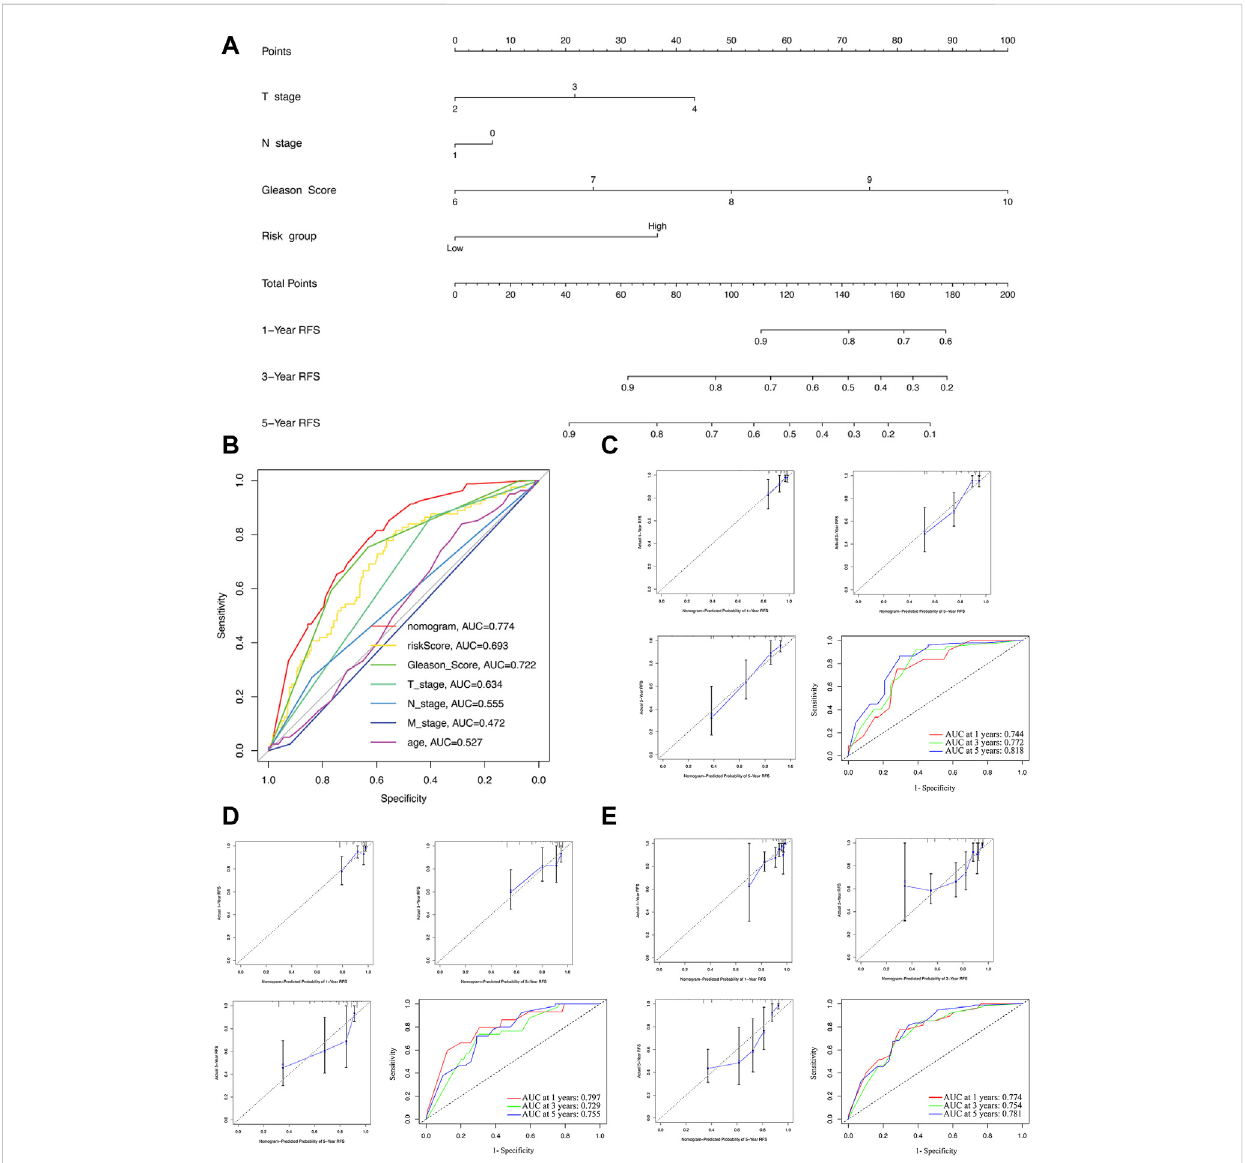
FIGURE 6 Constructionandevaluationofthenomogram. (A) Thenomogramcombiningtheriskscoreandclinicopathologicalfeatures. (B) ROCcurveanalysis of the nomogram, risk score and clinicopathological features. Evaluation of the nomogram model with calibration curves in 1, 3, and 5 years and ROC curves analysis in the training (C) , test (D) , and whole sets (E)